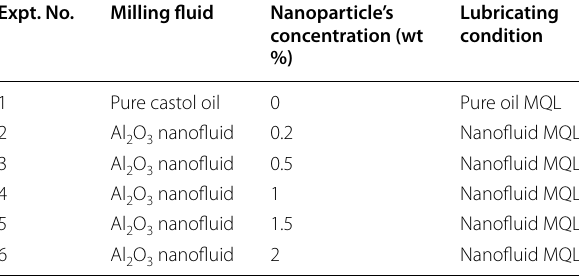
Table 4 Experimental design Expt. No.